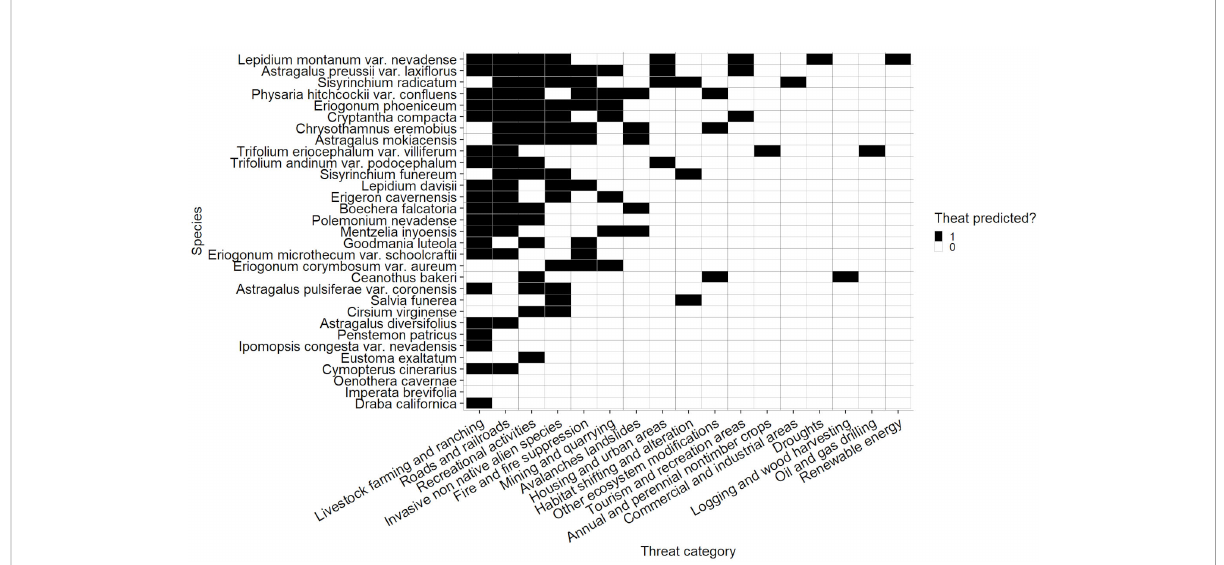
FIGURE 7 Threats predicted for rare species with threats unknown. Species are arranged in order of number of predicted threats along the Y axis. Black cells correspond to threats that are predicted, and white cells correspond to threats that are not